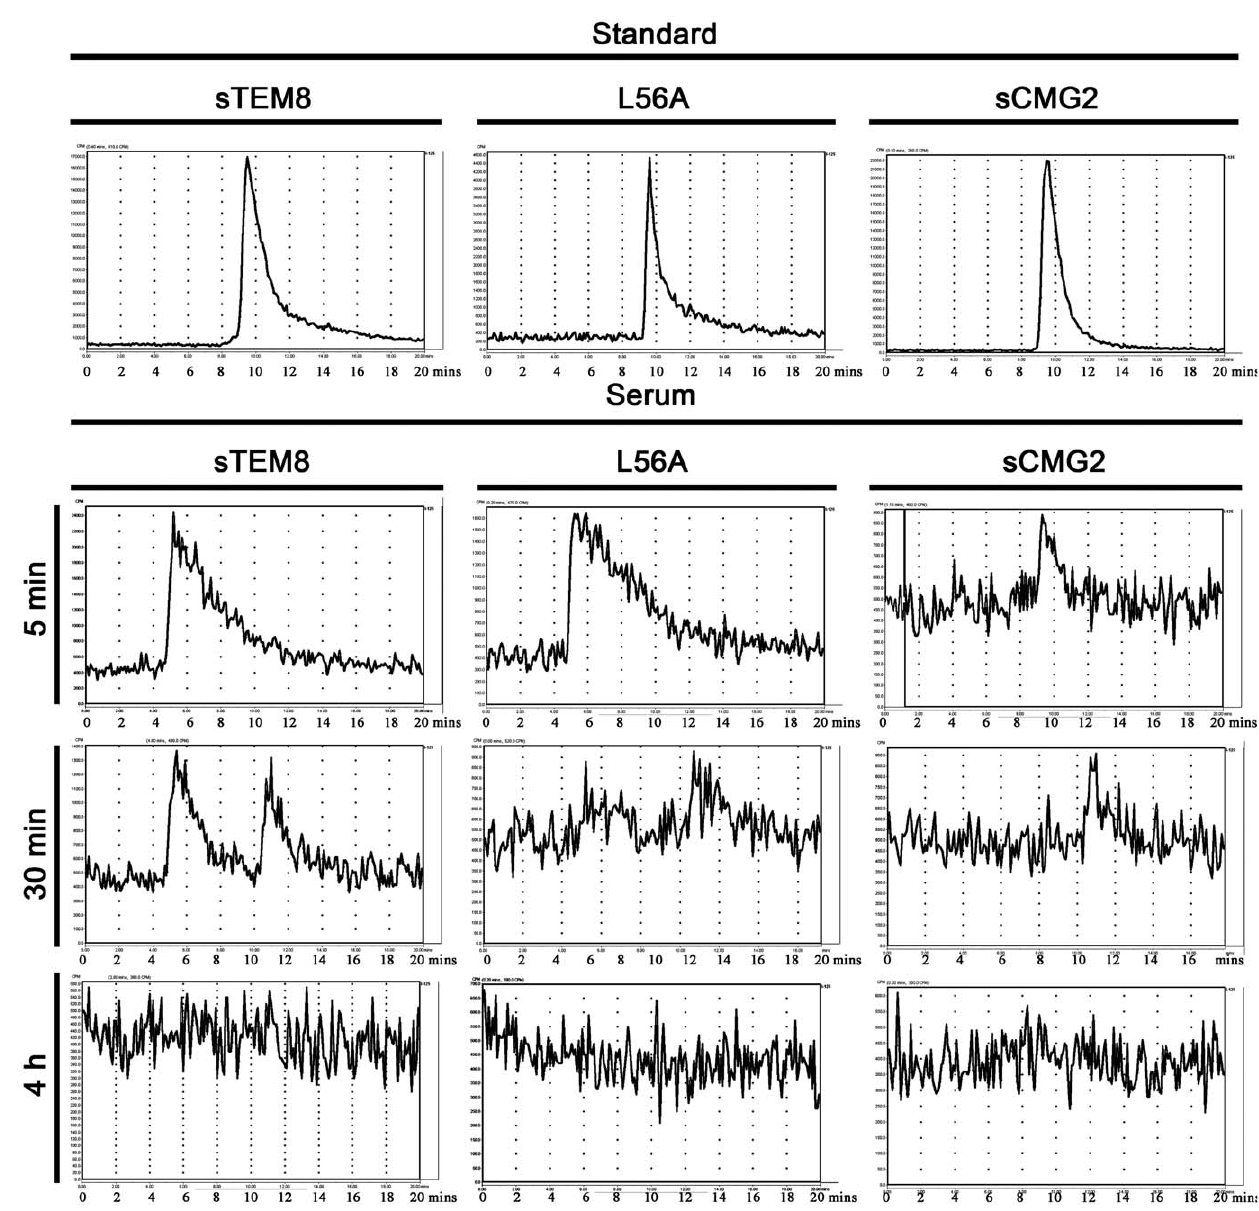
Figure 3. Plasma protein binding of the receptor decoys invivo . Rats were i.v. injected with 125 I-L56A, 125 I-sTEM8, 125 I-sCMG2 at a dose of 67.5 g/kg via the tail vein (at volume 250 m l). The serum samples collected at 5 min, 30 min, and 4 h after dosing were analyzed by size exclusion HPLC (TSK G3000 SWXL gel column)-flow scintillation analyzer (Radiomatic Model 600TRSeries, PerkinElmer, USA). For comparison, proteins labeled with 125 I were loaded directly on columns as standards. When compared with the peak of the standard, a faster peak implied plasma protein binding, whereas a delayed peak may represent degraded protein.